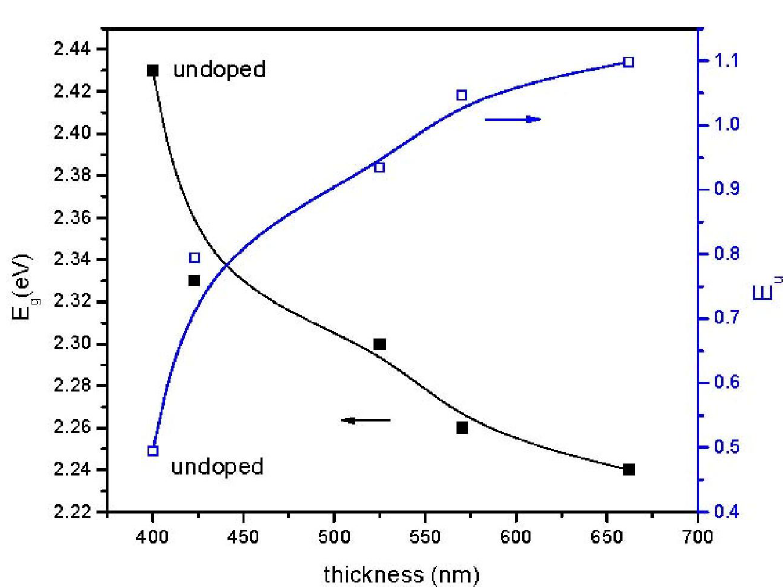
and E as a function of film g u